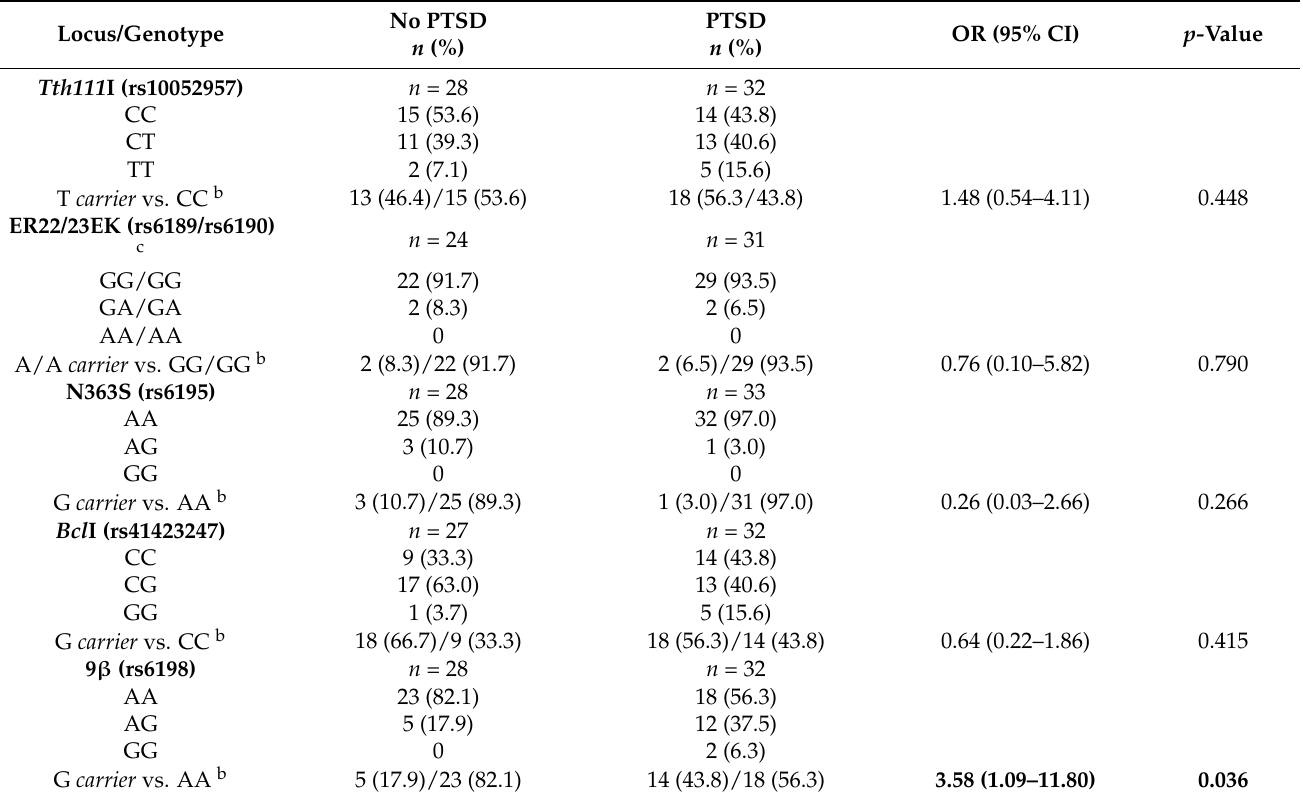
Table 1. Genotypic frequencies and association of the glucocorticoid receptor (GR) gene genetic variants 9 β , Bcl I, N363S, ER22/23EK, and Tth111 I with lifetime PTSD in war veterans a .